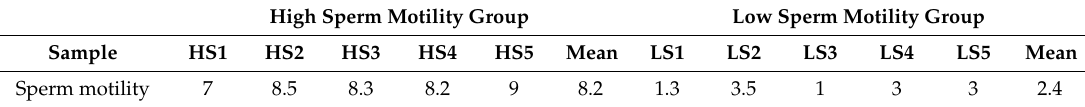
Table 1. Sperm motility of ten pigeons involved in